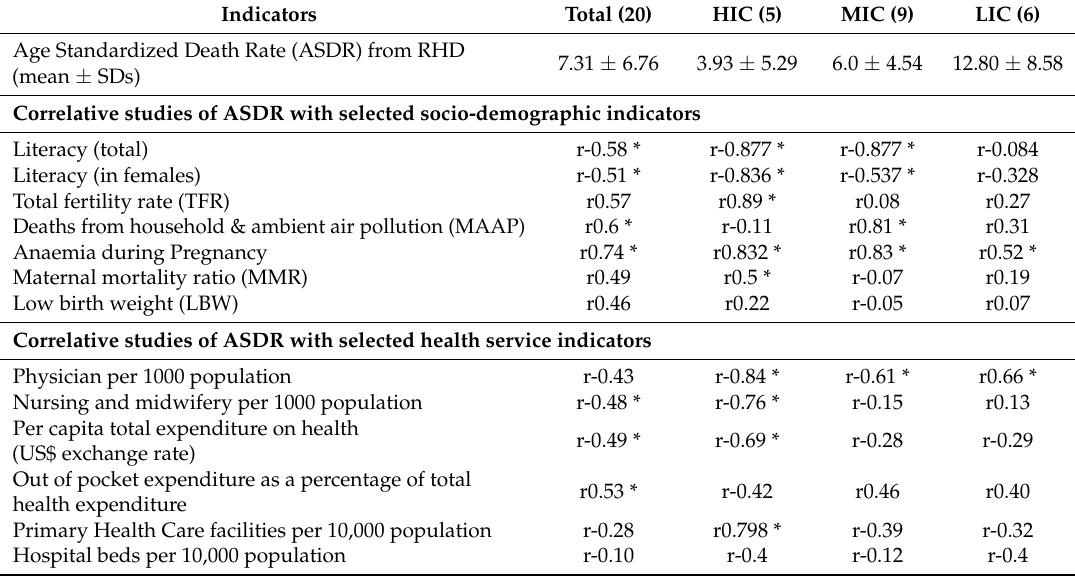
Table 1. Correlative studies between Age Standardized Death Rate (ASDR) per 100,000 from Rheumatic Heart Disease (RHD) with selected social demographic